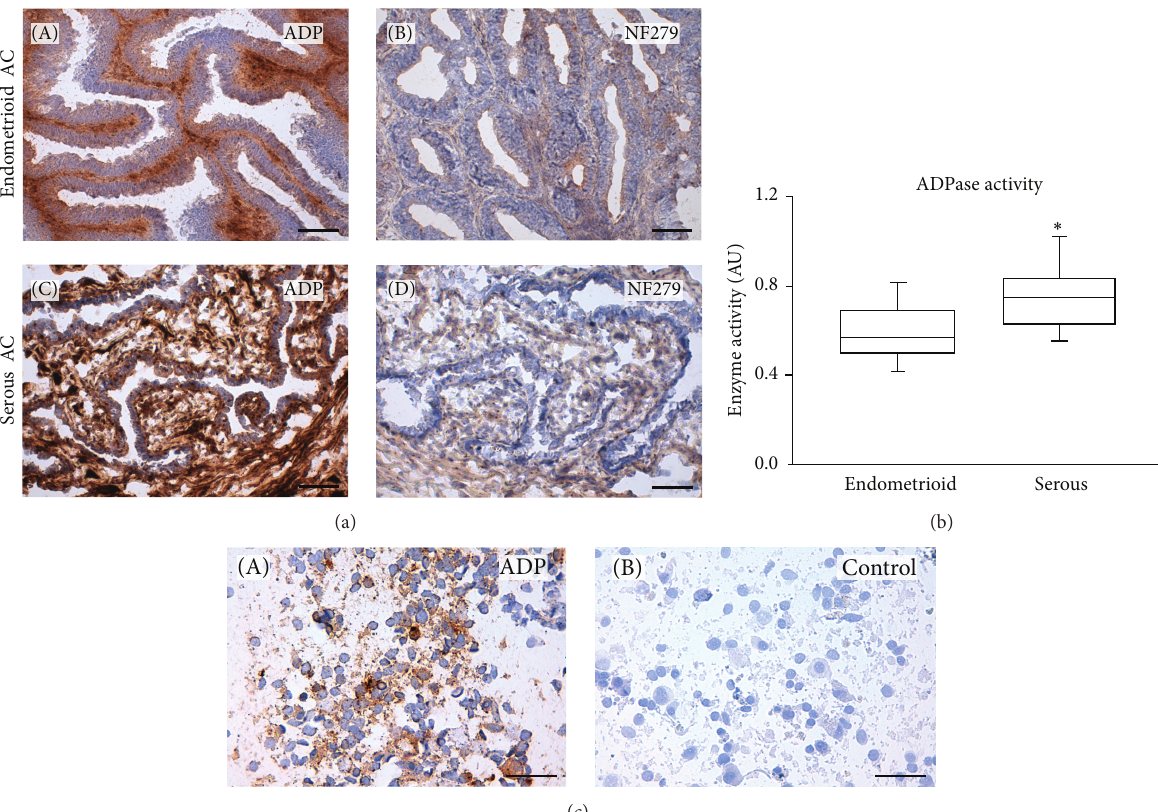
Figure 2: (a) Enzyme in situ histochemistry in endometrioid ((A), (B)) and in serous ((C), (D)) endometrial adenocarcinomas in the presence of ADP as substrate, alone ((A), (C)) or together with the inhibitor NF279 ((B), (D)). Strong ADPase activity was detected in the stroma of both types of tumors ((A), (C) dark brown deposits), while the activity was drastically reduced in the presence of the inhibitor ((B), (D)). Scale bars = 100 𝜇 m. (b) ADPase enzyme activity in tissue homogenates of endometrioid ( 𝑛 = 12 ) and serous ( 𝑛 = 14 ) adenocarcinomas. Experiments were performed in triplicate for each sample. Data are represented in arbitrary units (AU). ∗ Significant differences at 𝑃 < 0.05 . (c) ADPase in situ activity in endometrial touch preparations from human endometrioid adenocarcinomas using ADP as substrate (A) and in the absence of substrate (B). Scale bars = 50 𝜇